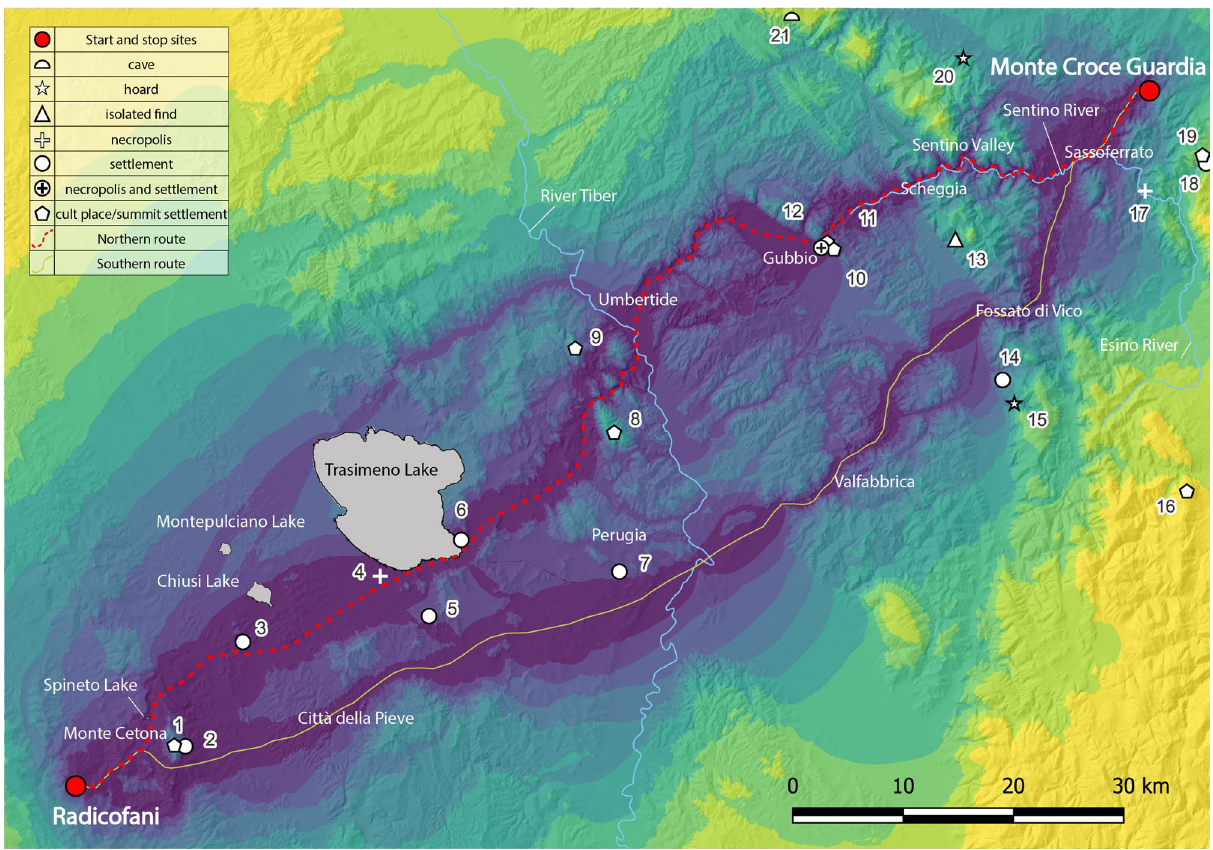
Figure 7. Map showing the results of the corridor analysis based on the wcs function. Cooler colours indicate the most convenient paths. The dashed red line (Northern route) suggests the best pathway. Numbers refer to the different contexts of the Final Bronze Age archaeological sites: 1 Monte Cetona (summit); 2 Case Carletti; 3 Chiusi; 4 Panicarola; 5 Monte Solare; 6 San Savino; 7 Perugia—Via Settevalli; 8 Monte Tezio; 9 Monte Acuto; 10 Gubbio—Via dei Consoli e Vescovado; 11 Monte Ansciano; 12 Monte Ingino; 13 Costacciaro; 14 Colle Mori; 15 Gualdo Tadino—hoard; 16 Monte Primo; 17 Pianello di Genga; 18 Gola della Rossa; 19 Monte Murano; 20 Frontone—Chiuse; 21 Fondarca—Grotta delle